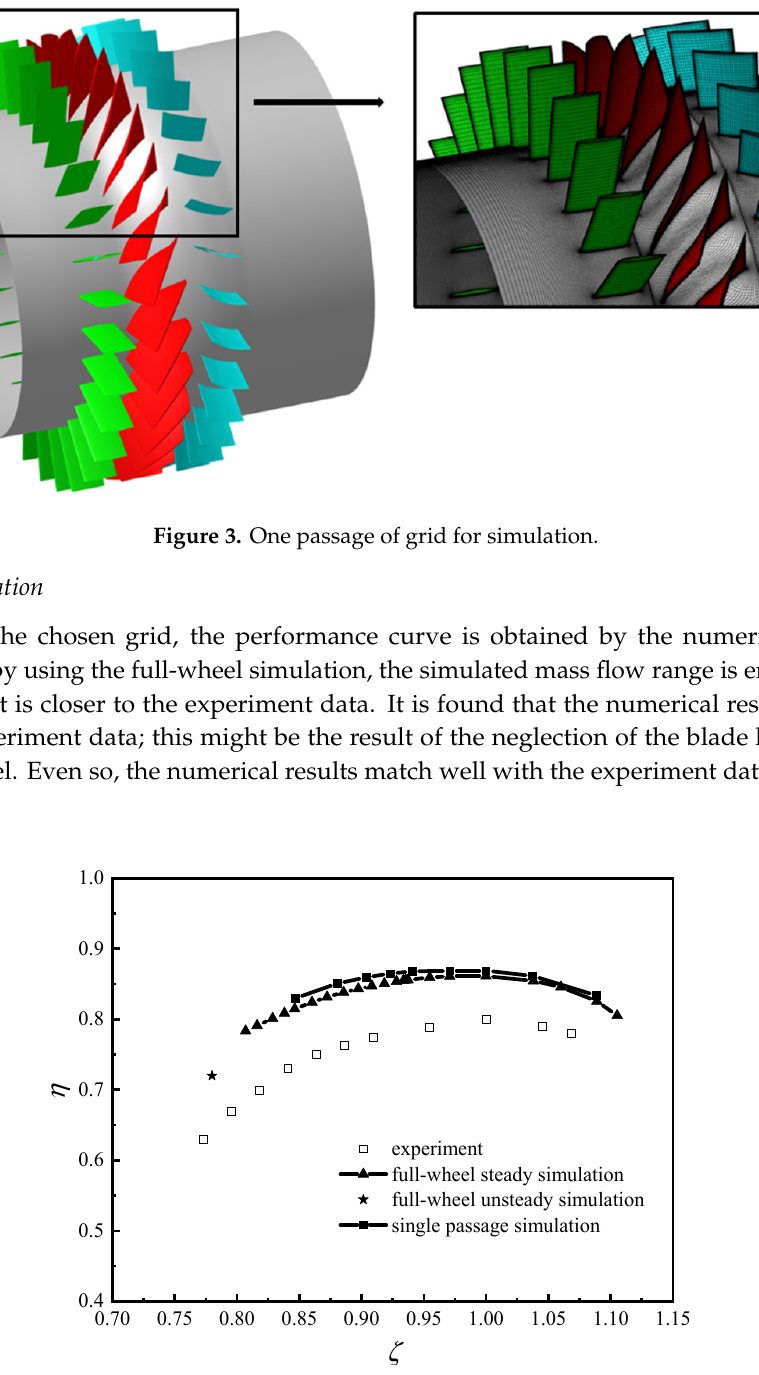
Figure 4. Performance comparison between experimental and numerical results.